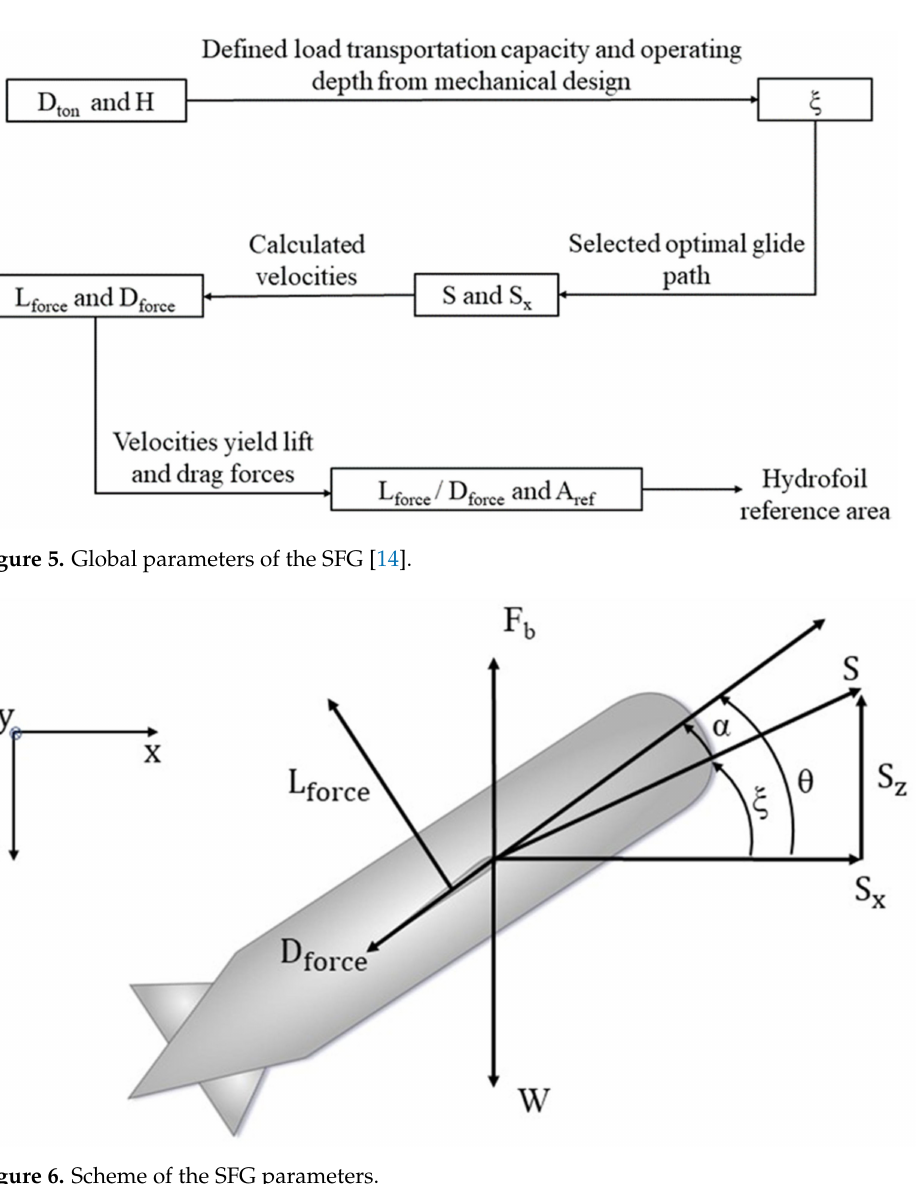
Figure 6. Scheme of the SFG